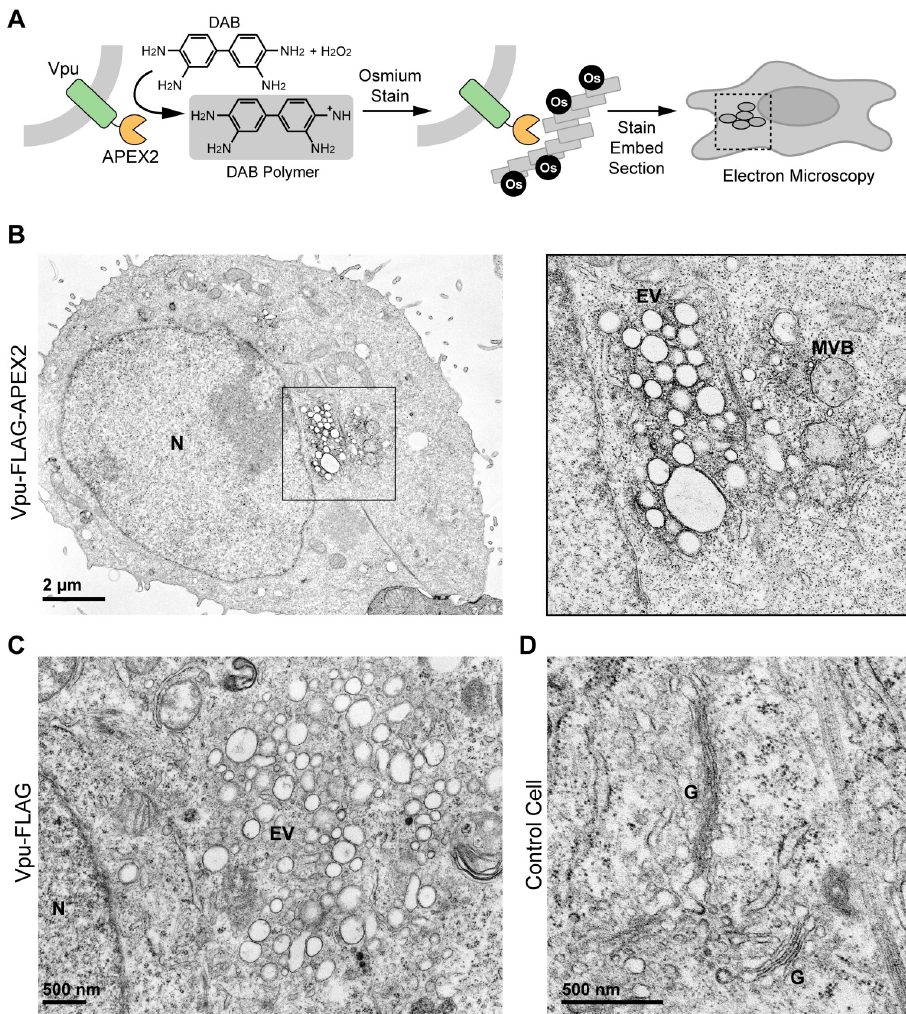
Fig 2. Vpu-APEX2 localizes to enlarged juxtanuclear endosomes and the limiting membranes of multi-vesicular bodies. (A) Schematic depicting APEX2 staining protocol for visualization by electron microscopy. (B) HeLa P4.R5 cells were transfected with the codon-optimized Vpu constructs bearing a C-terminal APEX2 tag. 24 hr later the cells were fixed before APEX2-dependent polymerization of DAB in the presence of hydrogen peroxide. The cells were then stained with OsO 4 , processed, and imaged by transmission electron microscopy (TEM). Left panel: Cells expressing Vpu-APEX2 contain juxtanuclear accumulations of osmium-highlighted enlarged vesicles (EV) likely derived from the Golgi and endosomes. Right panel: a higher magnification image of the juxtanuclear region of the cell shown at left. The limiting membranes of vesicles resembling multivesicular bodies (MVB) are highlighted by osmium. (C) Cells expressing Vpu (without an APEX2 tag) also contain enlarged juxtanuclear vesicles. (D) A control image showing Golgi (G) stacks in non-transfected HeLa P4.R5